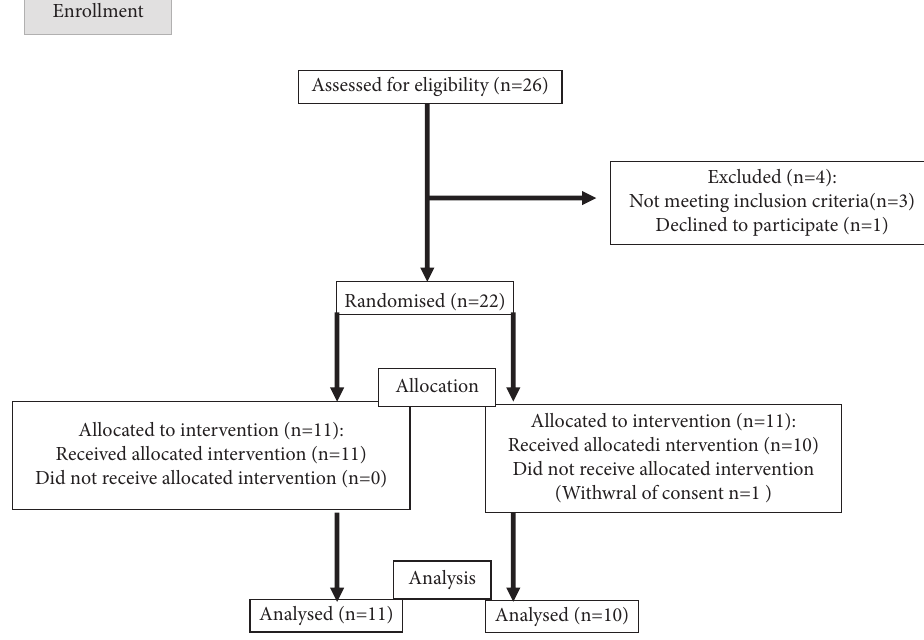
Figure 1: Flow diagram of the study